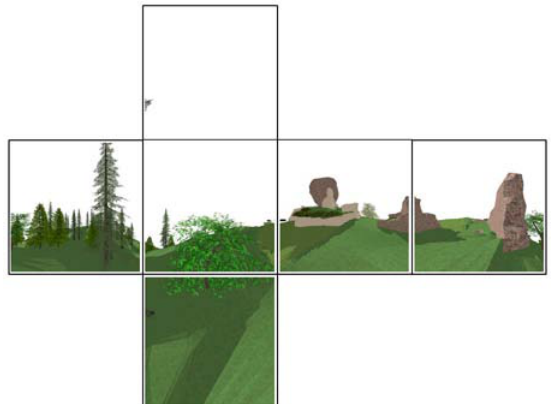
Figure 2. Cubic format: panorama made of 6 square pictures